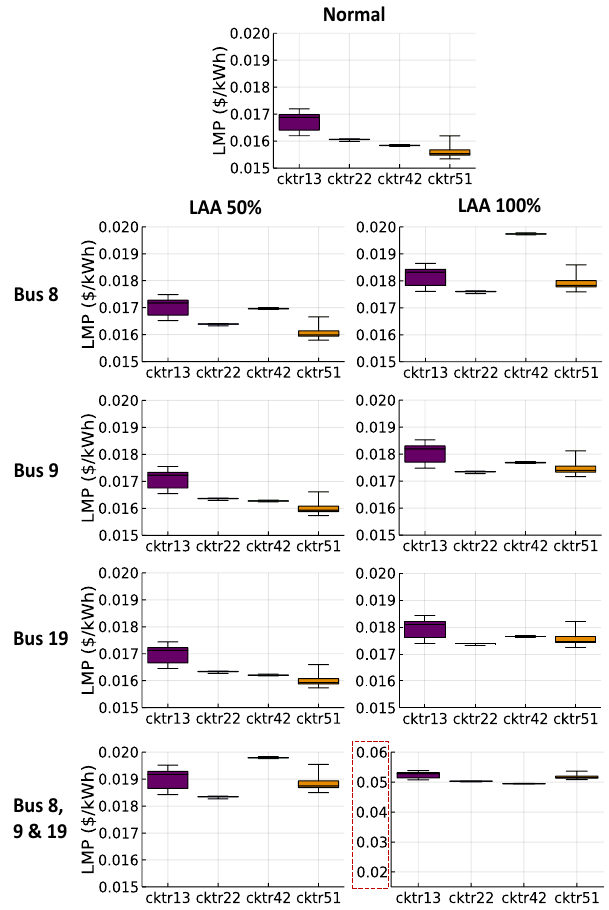
Figure 5. Box plots for LMPs in the distribution systems (i.e., cktr13, cktr22, cktr42, and cktr51). Rows indicate the bus targeted by the LAA, and columns represent the percent load increase at that bus (i.e., 50% or 100%). The red box indicates that in the last graph the y -limits are different, so that the corresponding LMP values could be